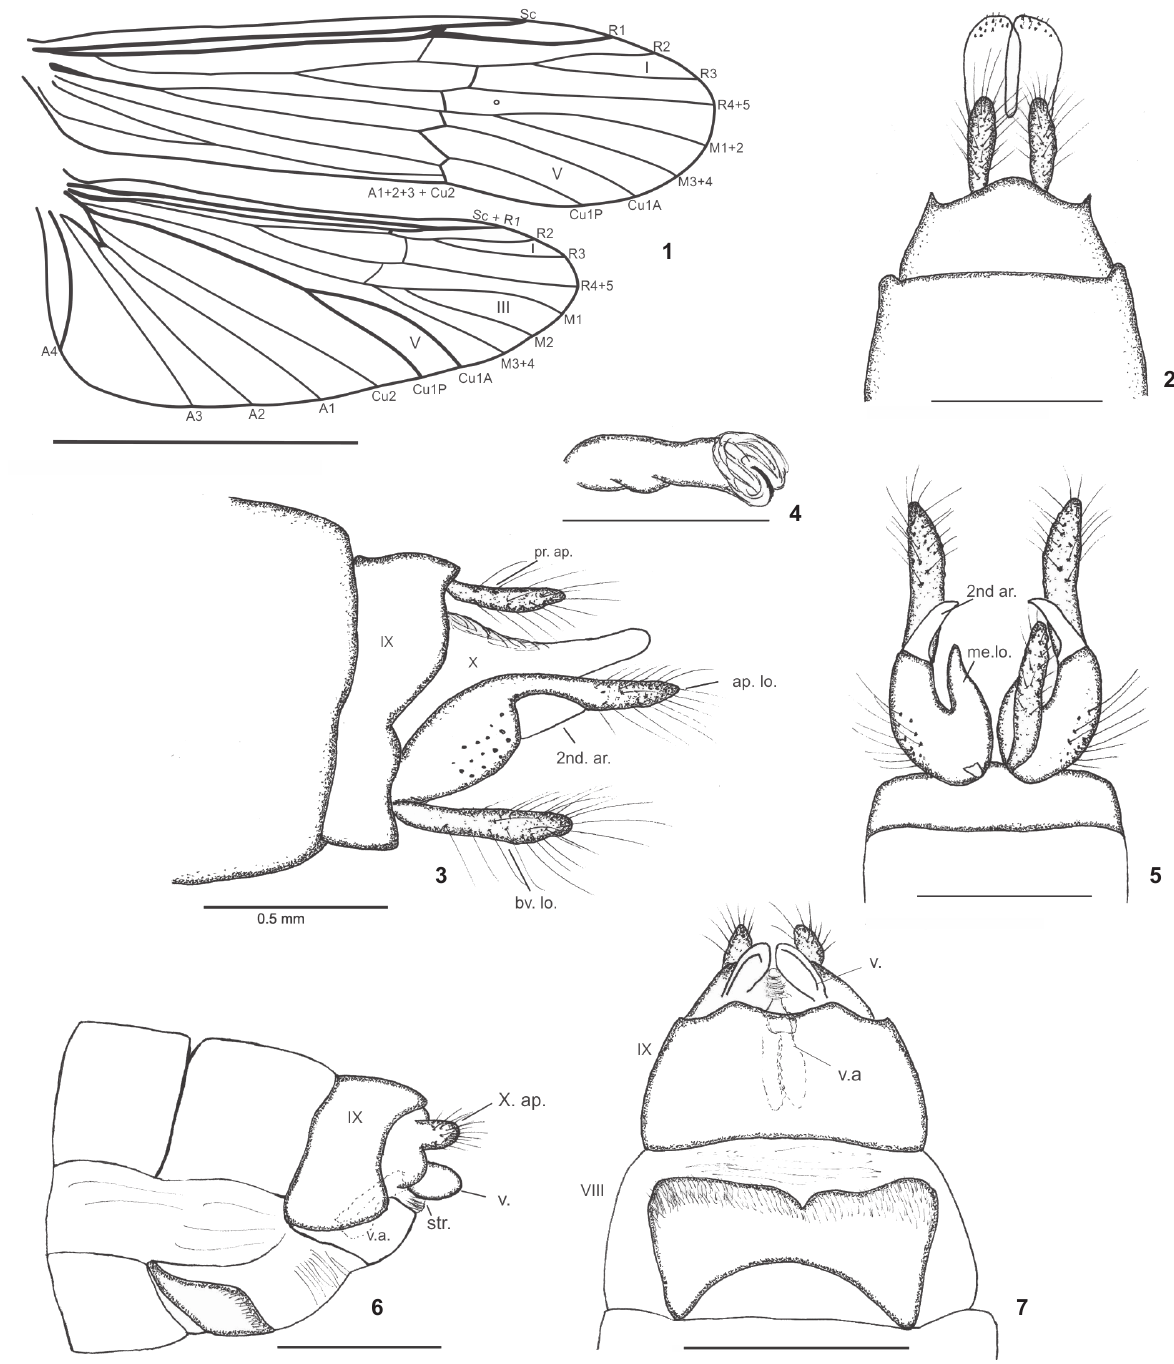
Figures 1-7. Triplectides cipo sp. nov. (1-5) Male: (1) fore and hind wings; (2) genitalia, dorsal view; (3) genitalia, lateral view; (4) phallic apparatus, lateral view; (5) genitalia, ventral view. (6-7) Female: (6) genitalia, lateral view; (7) genitalia, ventral view. (IX) Tergum IX, (X) Tergum X, (pr. ap.) preanal appendages, (ap. lo.) apicodorsal lobe, (bv. lo.) basoventral lobe, (me. lo.) mesal lobe, (2nd ar.) second article, (X. ap.) appendages of segment X, (v.) valves, (str.) striae, (v.a.) vaginal apparatus. Scale bars: 1 = 5.0 mm, 2-5 = 0.5 mm, 6-7 = 1.0 ZOOLOGIA 32 (1): 66–70, February 2015